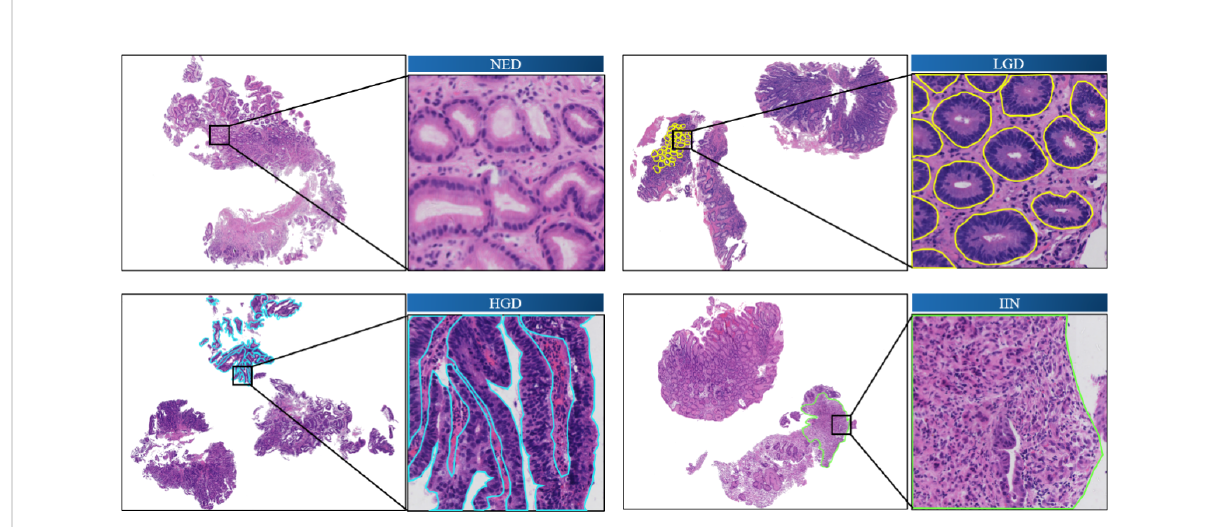
FIGURE 1 Annotated images of slide-mounted endoscopic biopsy specimens. Representative images of four categories (NED, LGD, HGD, and IIN) of gastric biopsy are presented. The abnormal regions distinct for each category are annotated with different colors. One local area is selected in each slide as a closeup image. HGD, high-grade dysplasia; IIN, intramucosal invasive neoplasia; LGD, low-grade dysplasia; NED, negative for